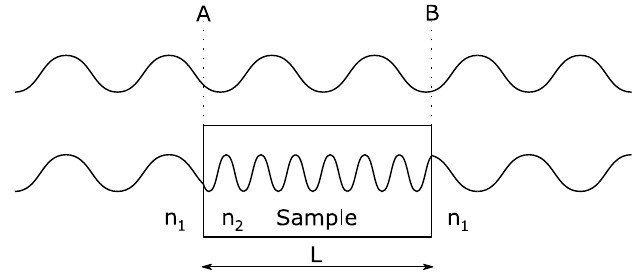
Figure 4. Dispersion in the measured medium.